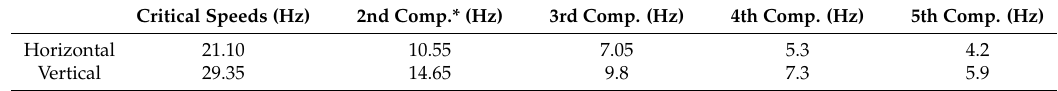
Table 3. Critical speed and subcritical frequencies.